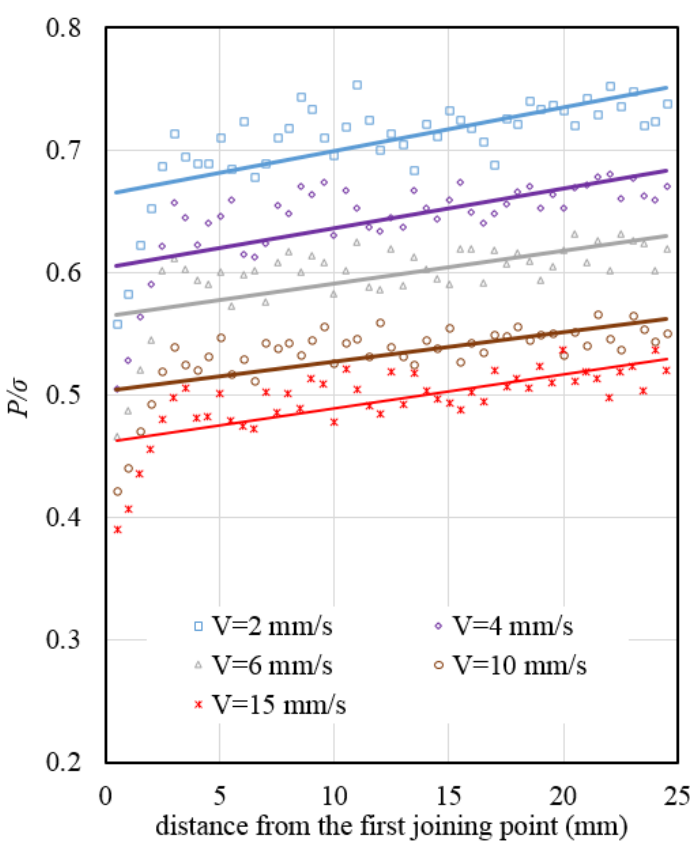
Figure 7. Ratio of normal pressure to effective stress ( P / σ ) at different ram speeds at a billet temperature of 470